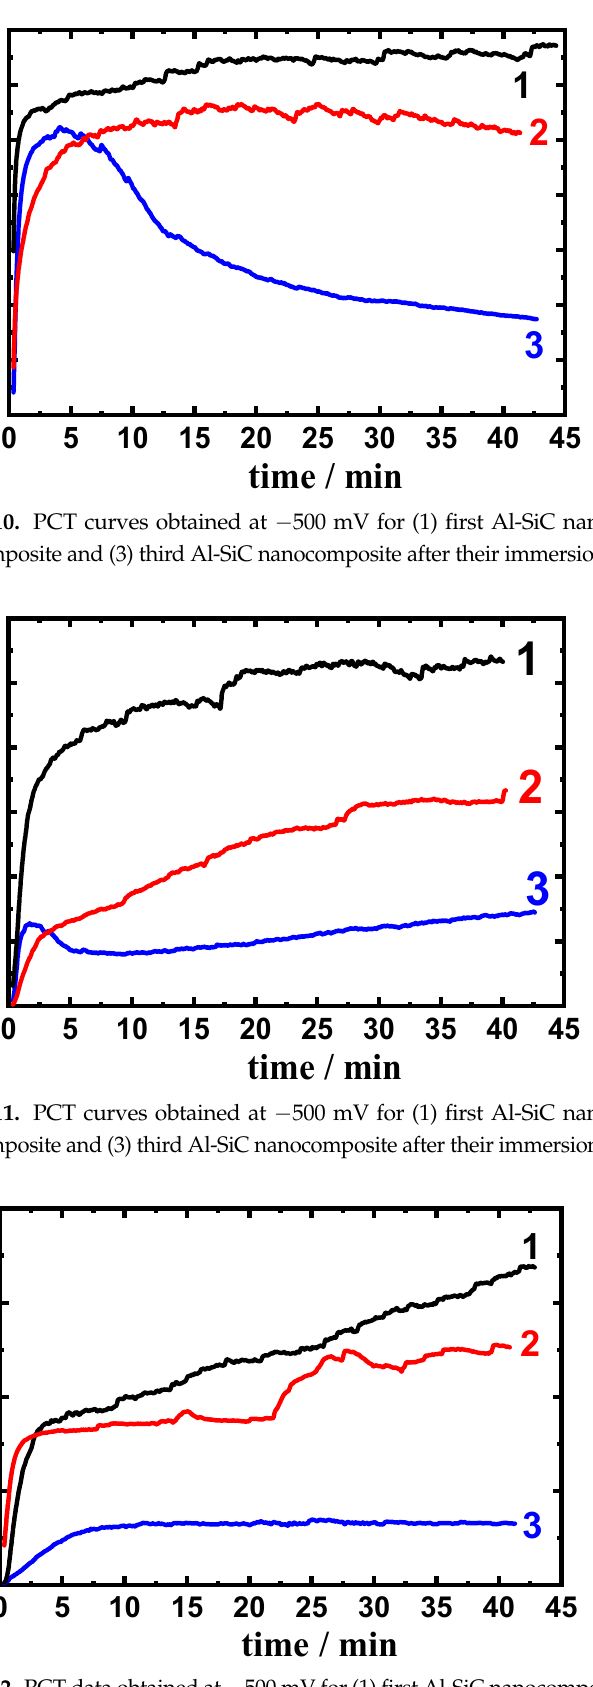
Figure 12. PCT data obtained at − 500 mV for (1) first Al-SiC nanocomposite, (2) second Al-SiC nanocomposite and (3) third Al-SiC nanocomposite after their immersion in 3.5% NaCl solutions for 48 h.